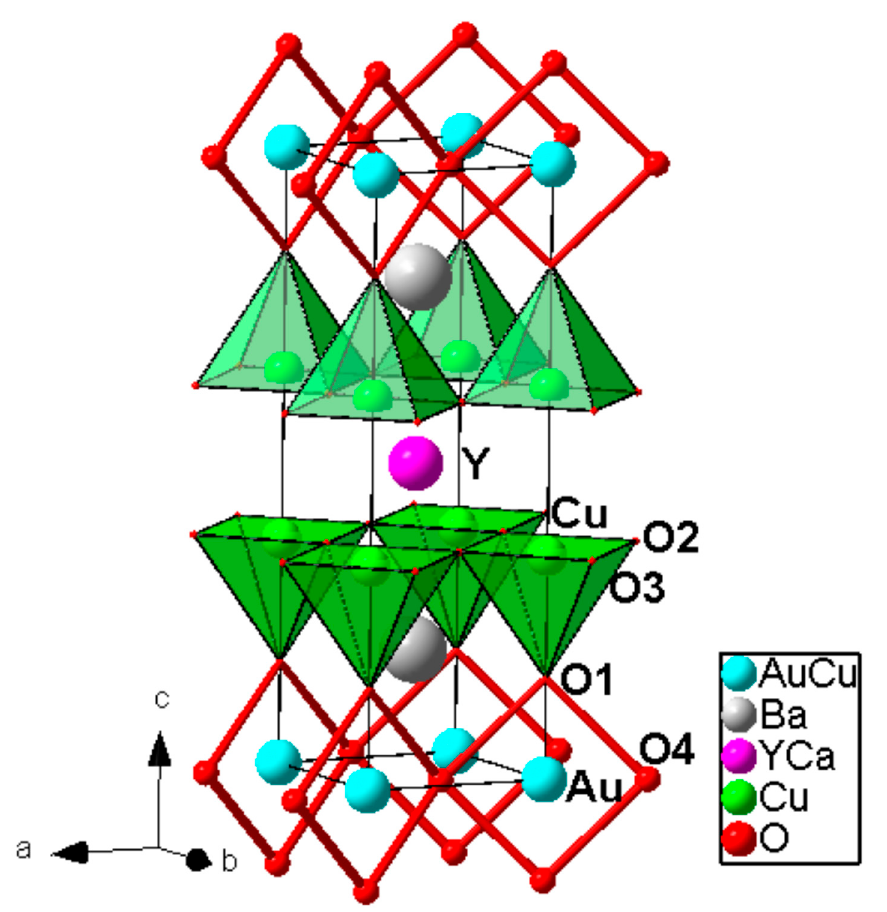
Figure 2. Crystal structure of the Au-1212 compound. Zigzag chain of AuO4 square-planar units is selected. Reproduced with permission from [9].